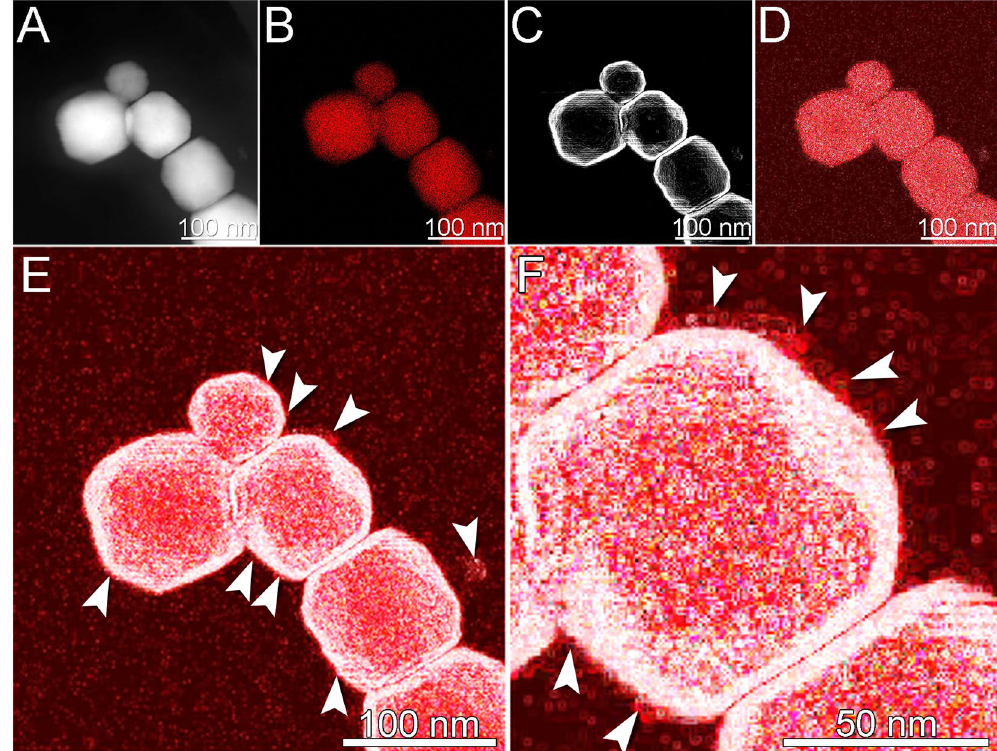
Figure 4. STEM images and EDS elemental maps of magnetosome chains from cells of cultured Magnetofaba australis strain IT-1. ( A ) HAADF image of a Fe 3 O 4 magnetosome chain. ( B ) Fe map of the chain shown in ( A ). ( C ) Edge detection algorithm image of the STEM image shown in ( A ). ( D ) Edge detection algorithm image of the Fe map shown in ( C ). ( E ) Overlay image of the processed STEM ( C ) and the Fe map ( D ). ( F ) High magnification of the overlay image shown in ( E ). Arrows indicate regions of significant Fe accumulation around the magnetosome Fe 3 O 4